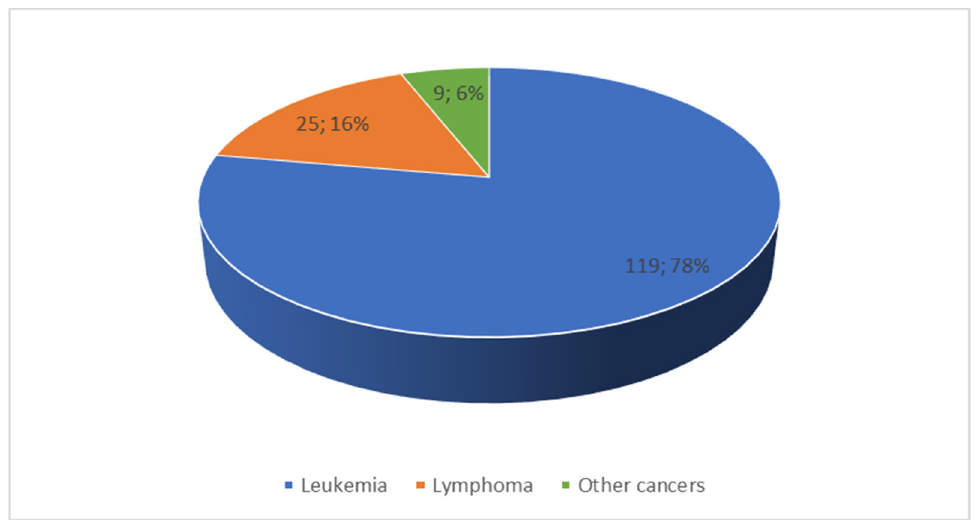
Figure 1. Diagnoses in children with cancer.